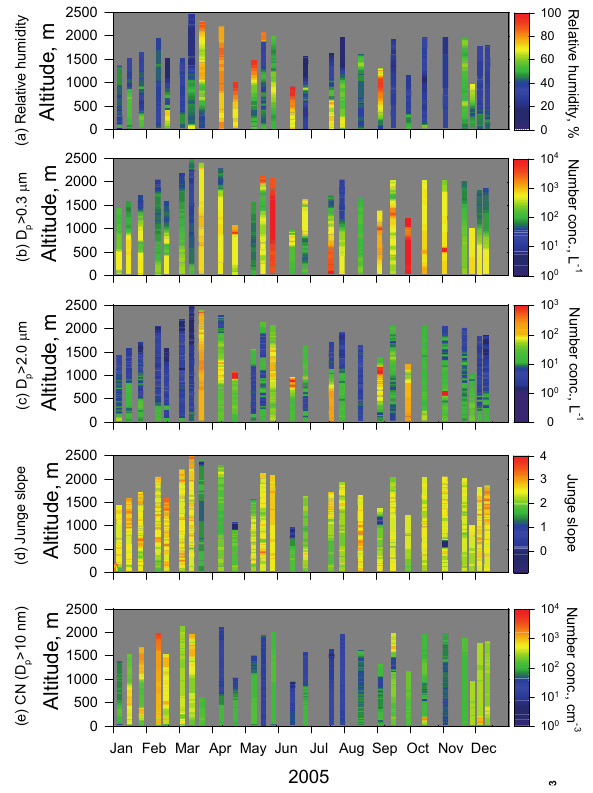
Fig. 3. Seasonal and vertical features of (a) relative humidity, (b) the number concentration of aerosols ( D p > 0 . 3µm), (c) the num- ber concentration of aerosols ( D p > 2 . 0µm), (d) Junge slope, and (e) CN concentration, at Syowa Station,